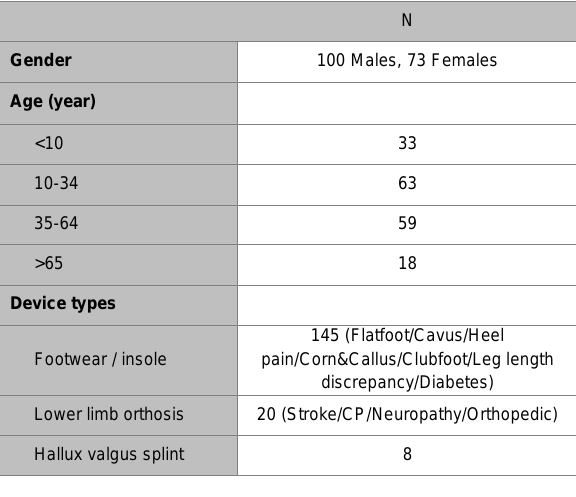
Table 1: Demographic characteristics and device